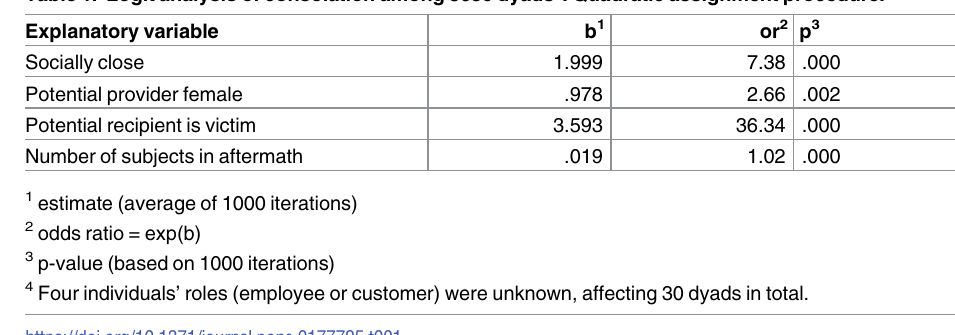
Table 1. Logit analysis of consolation among 3680 dyads 4 . Quadratic assignment